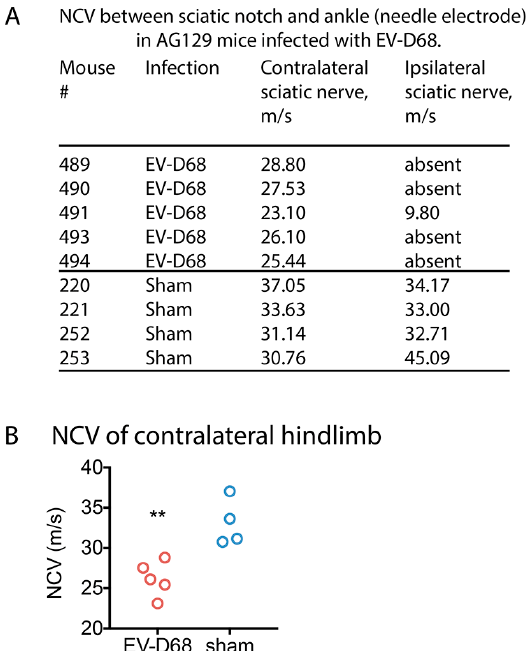
Figure 3. Reduced nerve conduction velocity (NCV) in AG129 mice infected with EV-D68 six weeks after onset of paralysis. ( A ) NCVs among EV-D68-infected and sham-infected mice; ( B ) NCV of contralateral EV-D68 (red circle) and sham (blue circle) hindlimbs. ** p < 0.01 using t -test, # mouse ID number.